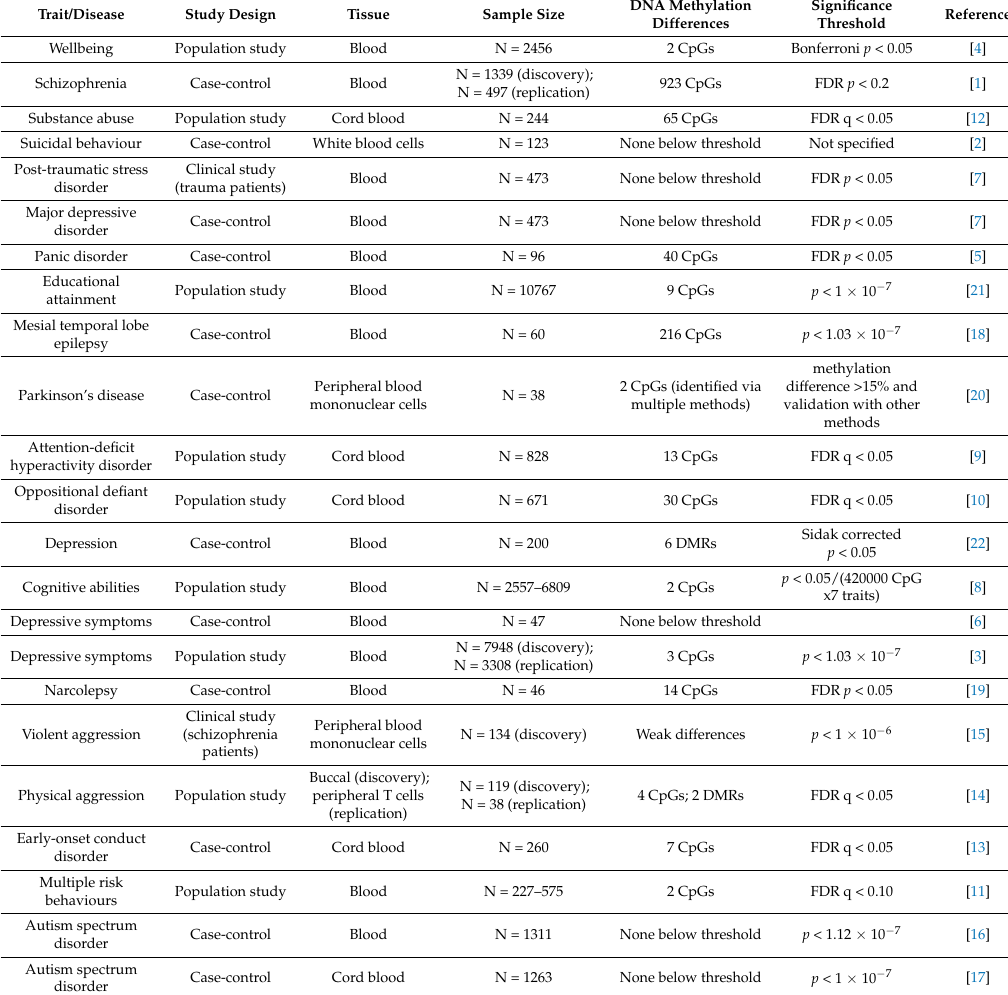
Table 1. Epigenome-wide association studies of mental health traits and diseases conducted in peripheral blood. A semi-systematic PubMed search was undertaken (access date 21/11/2018) using the terms ‘DNA methylation’, ‘methylome-wide’, ‘epigenome-wide’, ‘psychiatry’, ‘psychiatric’, ‘behaviour’ and ‘human’. FDR: false discovery rate; DMR: differentially methylated